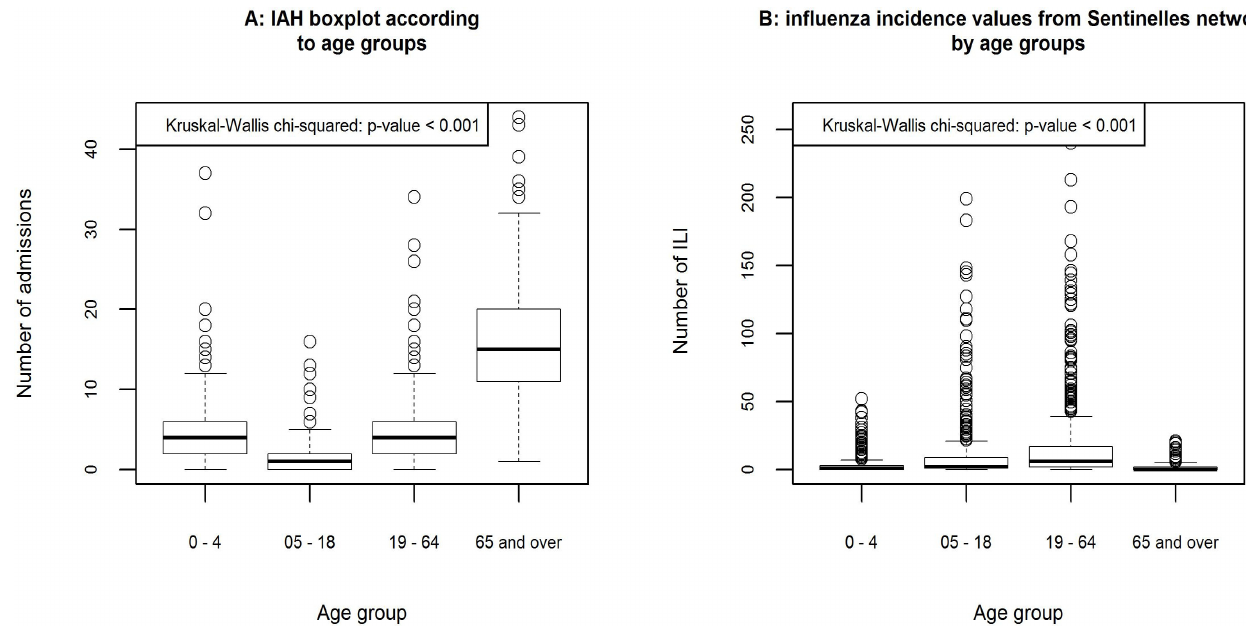
Fig 3. A: Influenza-Associated Hospitalizations (IAH) boxplot according to age groups; B: Boxplots of influenza incidence values (from Sentinelles network) by age groups.